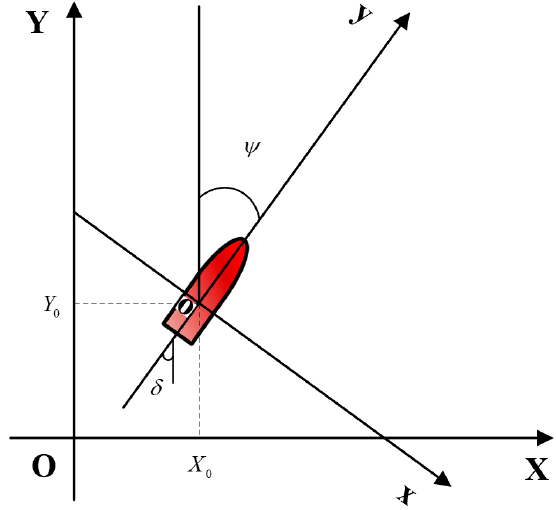
Figure 1. Coordinate system.